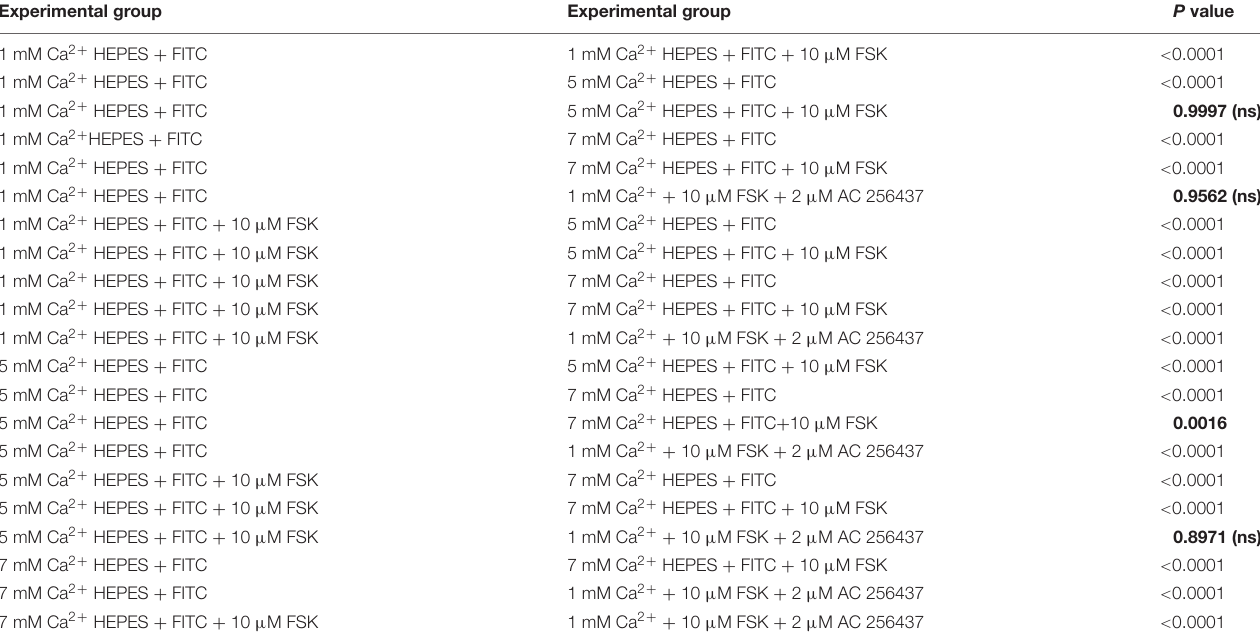
TABLE 5 | Middle region of small intestine. P values of (cid:49) Fluorescence/Minute with the different [Ca 2 + ] and FSK in comparison to AC-265347 with FSK. Experimental group Experimental group